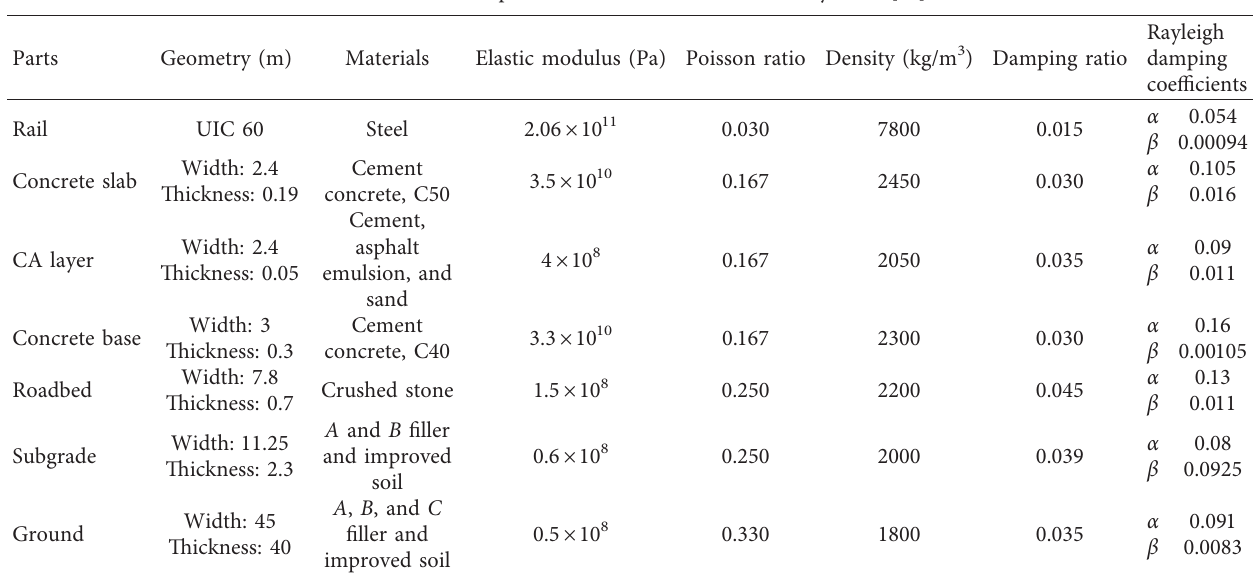
Figure 4: Vertical rail irregularities. Table 3: Material parameters of the ballastless railway track